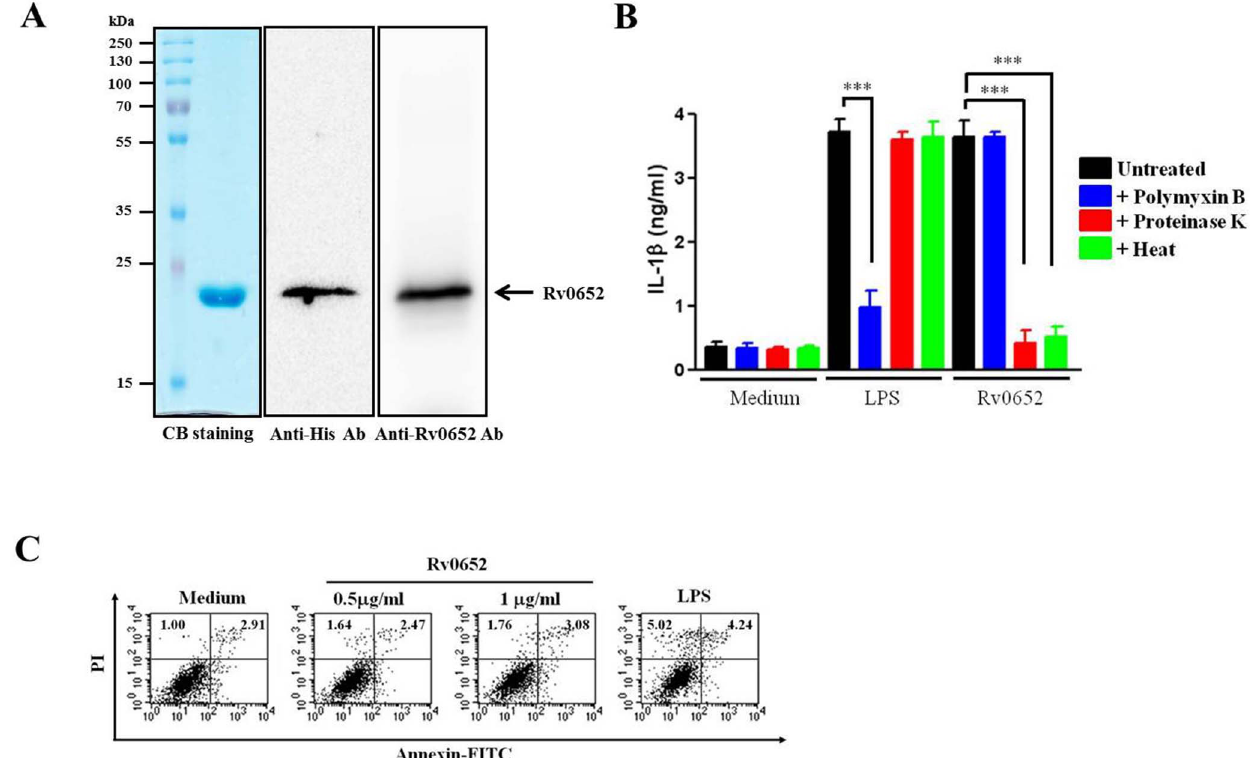
Figure 2. Purity and endotoxin contamination of the rRv0652 protein and its effect on cell viability. (A) Recombinant Rv0652 protein was purified with NTA resin, subjected to SDS-PAGE, and analyzed by using Coomassie blue (CB) staining (left panel) and immunoblot assay using anti-histidine and anti-Rv0652 antibodies (right panel). (B) DCs were stimulated with vehicle, Rv0652 (1 ug/mL), or LPS (200 ng/mL), and treated with/ without polymyxin B (10 ug/mL), proteinase K (5 ug/ml), or heat (100 u C for 30 min). Culture supernatants were harvested after 24 h, and IL-1beta levels were assessed by an ELISA. Data are the mean and SEM of 3 experiments. *** P , 0.001. (C) DCs were treated with the indicated concentrations of Rv0652 or LPS (200 ng/mL) for 24 h, stained with Annexin V and PI, and analyzed by flow cytometry. Results are representative of 4 separate experiments with similar results.